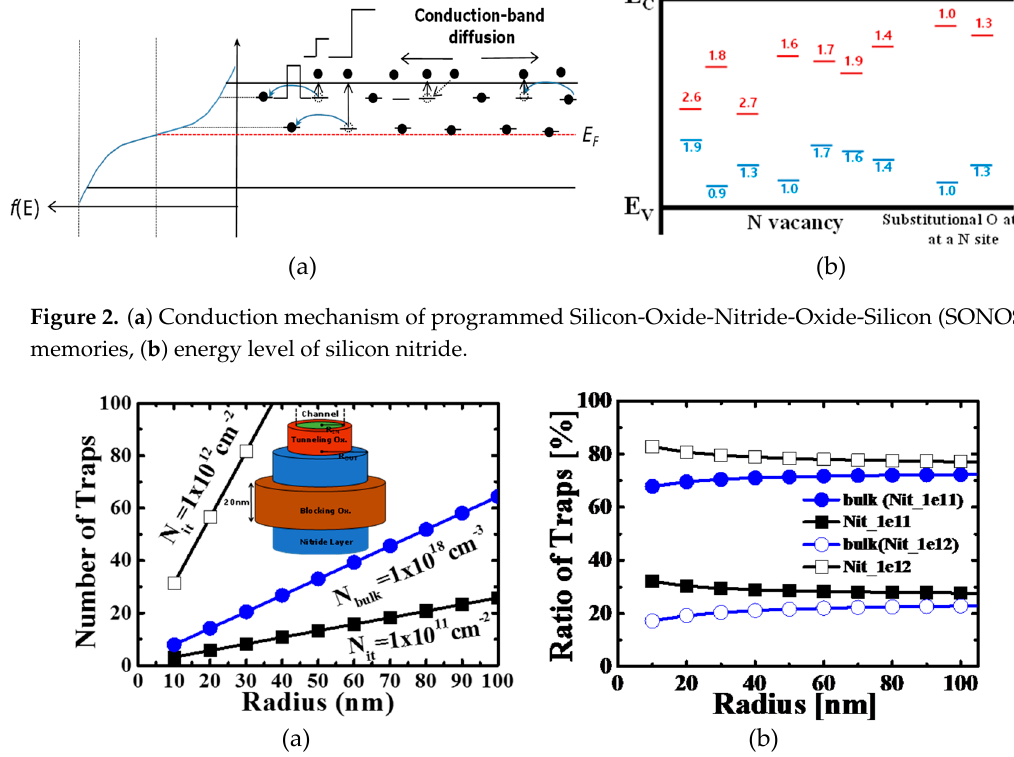
Figure 1. The charge trapping layer structure of ( a ) BiCS 3D NAND and ( b ) TCAT 3D NAND.